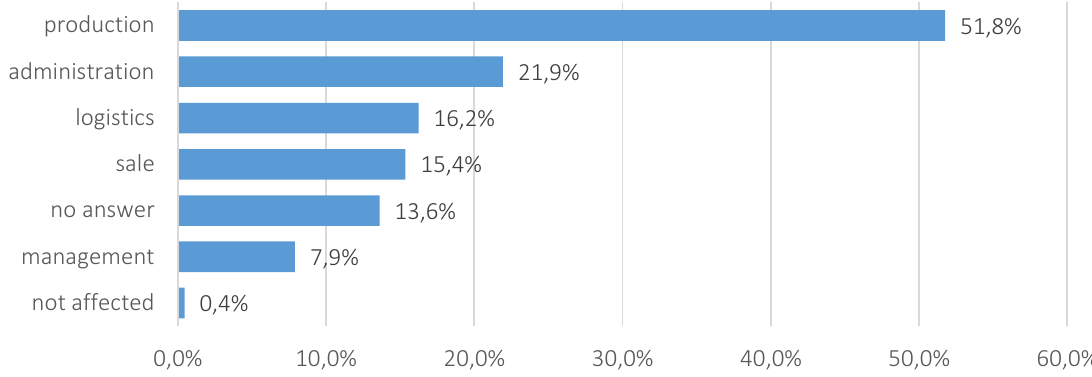
Figure 4. Employers’ views on the impact of Industry 4.0 within job creation